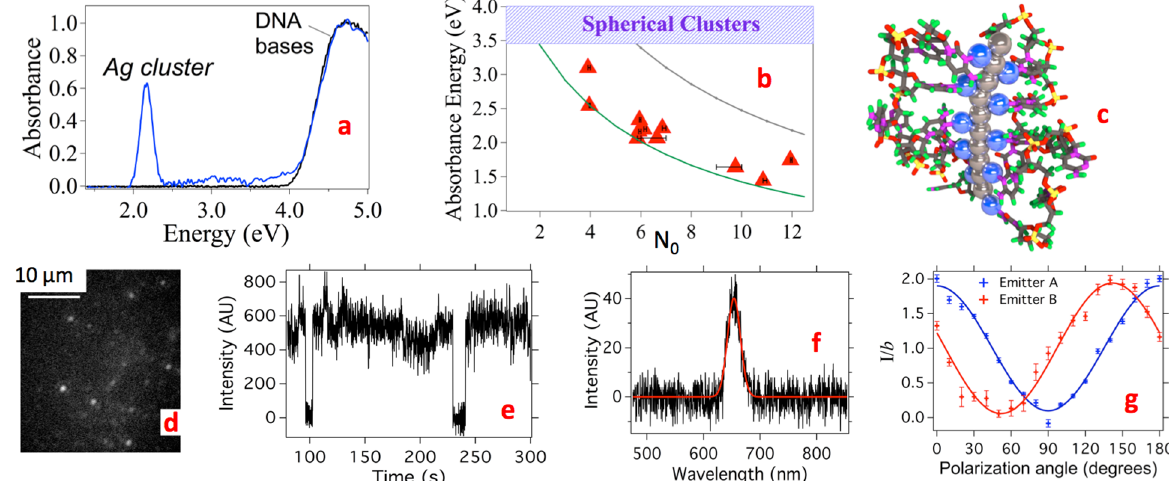
Figure 5. Optical properties of pure Ag N -DNA. (Adapted with permission from references [14,55]). ( a ) Fluorescent Ag N -DNA show a single absorbance peak (blue) at energies below the DNA peak. Black: DNA alone; ( b ) Peak absorbance energies of fluorescent Ag N -DNA (red) follow the same trend as predicted for Ag cluster rods with 1-atom cross section (green curve) [14]. Blue shading: Range of main absorbance peaks for same-size globular clusters. Gray curve: predictions for a thicker Ag cluster rod [53]; ( c ) Another example rod structure that is consistent with optical data and the measured N 0 and N + . The Ag° rod (gray) is shown attached to DNA bases via Ag + (blue) [14]; ( d – g ) Single Ag 15 -DNA at 2K (excited at 590 nm) [55]; ( d ) Wide field image shows bright spots from individual Ag 15 -DNA; ( e ) Observation of 1-step blinking between bright and dark states confirms emission from a single Ag 15 -DNA; ( f ) Spectra for individual Ag 15 -DNA remain spectrally broad at 2K, consistent with collective transitions [55]; ( g ) Dependence of emission on polarization for 2 individual Ag 15 -DNA. The high modulation index is expected for rod clusters